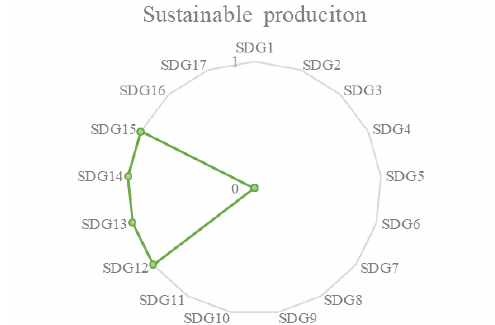
Figure 9. Sustainbale production cluster of application effect on the SDGs.